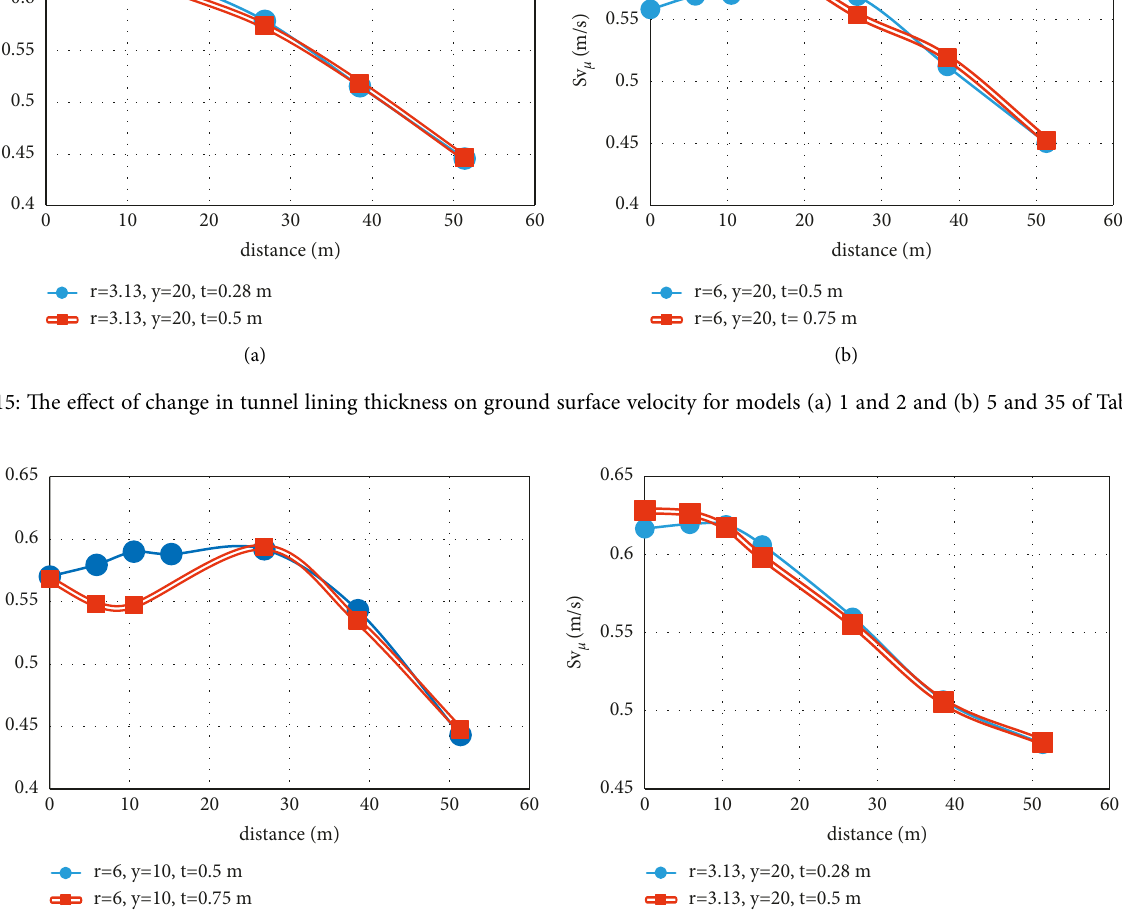
r=6, y=10, t=0.5 m r=6, y=10, t=0.75 Figure 16: The effect of change in tunnel lining thickness on ground surface velocity for models (a) 3 and 4 and (b) 10 and 11 of Table